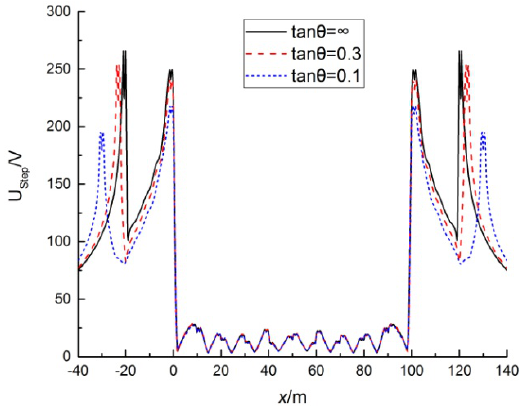
Figure 5. The change in step voltage with slope.